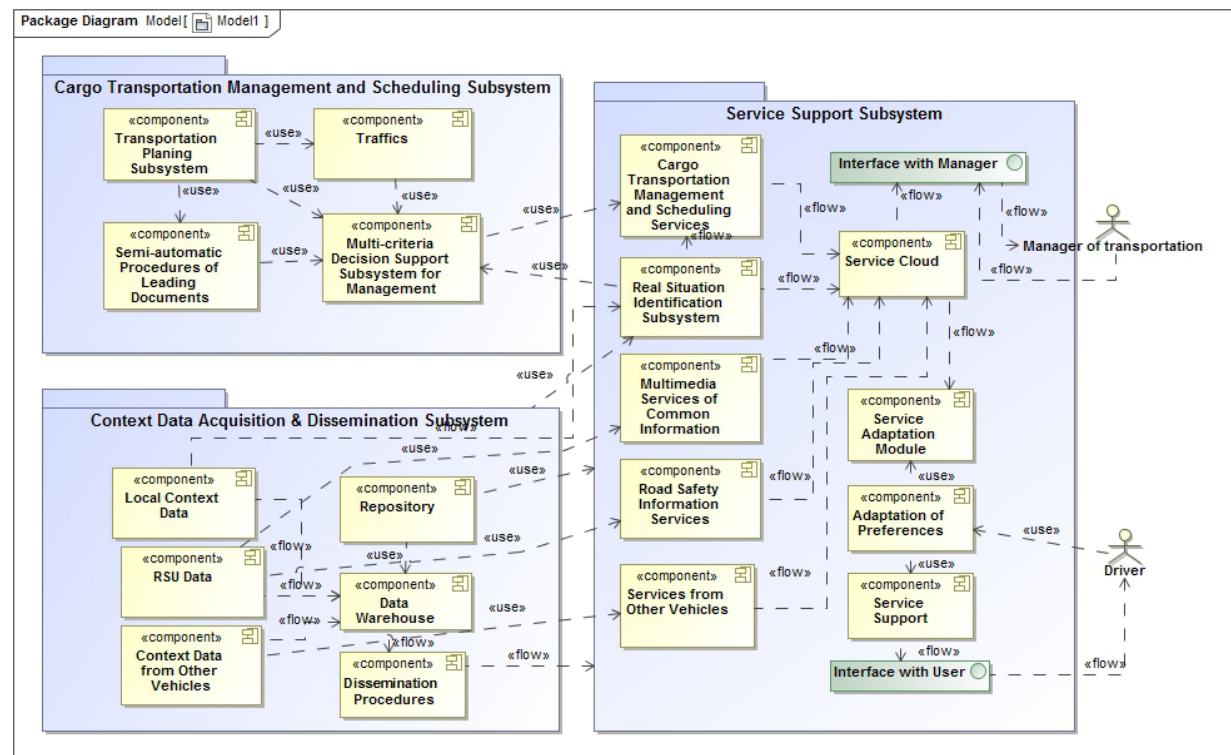
Figure 2. The architecture of the proposed IASDS for service delivery with the function of recognizing data from